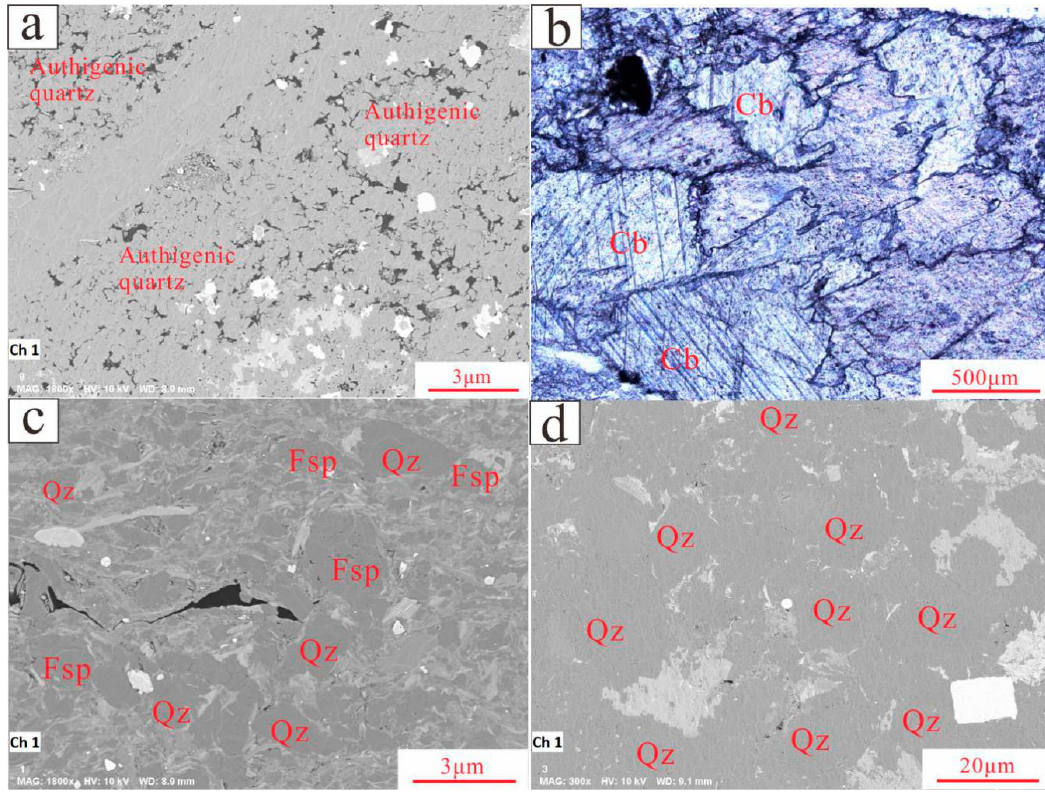
Figure 12. Microstructural characteristics of rock samples under an optical microscope and SEM; Qz (quartz); Fsp (feldspar); Cb (carbonate minerals). ( a ) Amount of authigenic quartz developed in sample 5; ( b ) Sample 9 mainly consists of carbonate minerals (75.7%), leading to high cohesion, and the rhombic cleavage of calcite is visible; ( c ) Microstructural characteristics of sample 3 in SEM, sample 3 is made up of the ideal content of various minerals (45% quartz, 16% feldspar, and 30% clay minerals), and the amount of weak mechanical structural surfaces in the rock is conducive to the development of fractures. ( d ). Under SEM, an excessive amount of quartz (72%) in sample 5 makes it hard to form fractures.